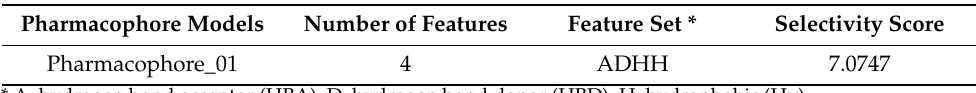
Table 1. Structure-based pharmacophore model summary with its generated features.